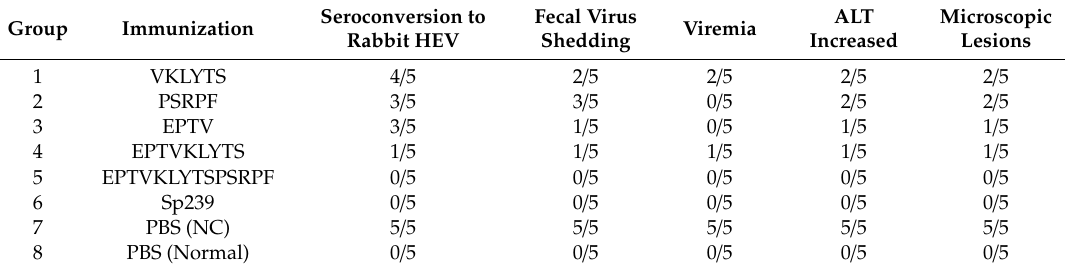
Table 1. Number of rabbits infected by CHN-SD-sHEV in di ff erent